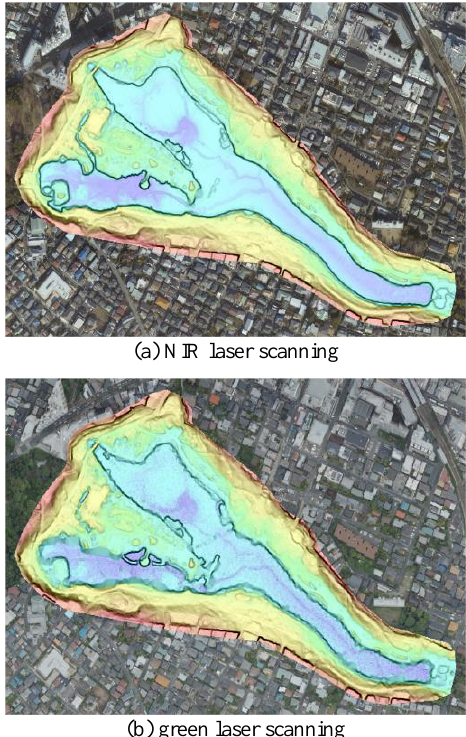
Figure 4. Colour shaded relief map of Inokashira Pond Comparing with the NIR laser scanning, the green laser scanning did not observe waterside of the pond well as Figure 5 shows. This is due to vegetation spread above the water. Green laser pulses were partially or even wholly reflected by the vegetation. On the other hand, there are two reasons